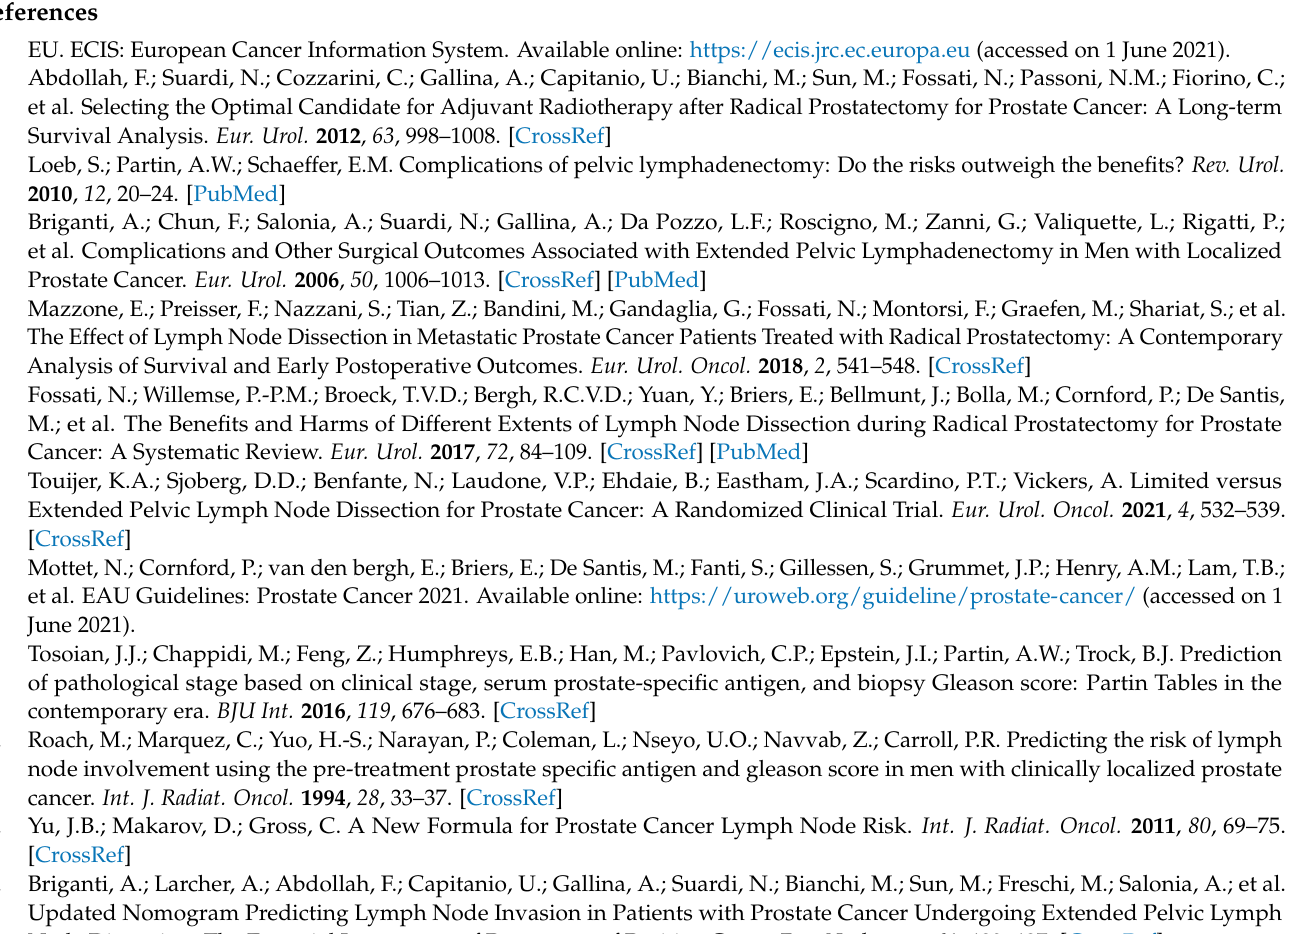
Table S11: Inter-reader variability assessment—LNI risk prediction; Table S12: Model performance according to the NCCN risk classification; Table S13: Radiomics Quality